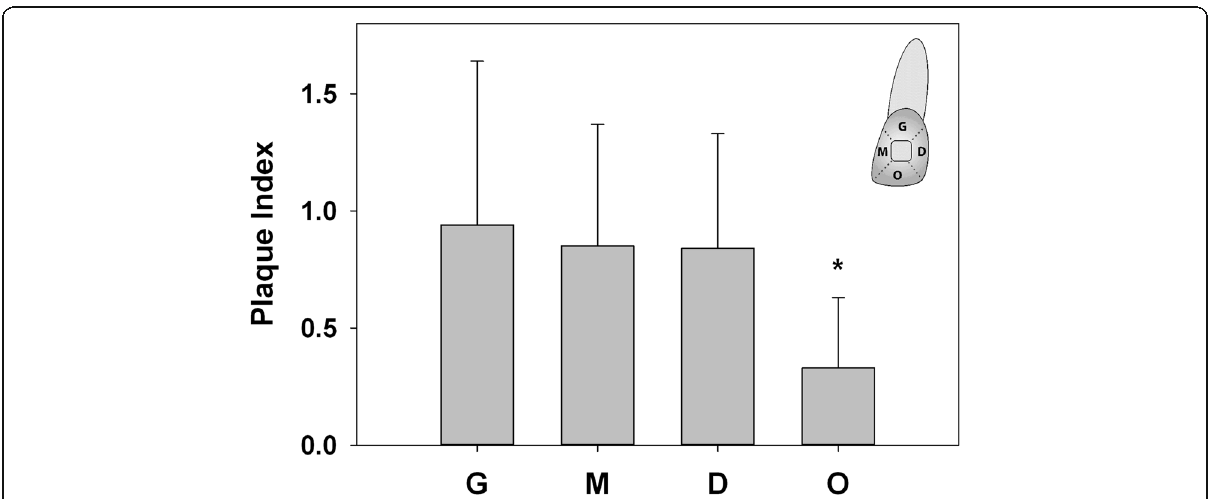
Fig. 1 Biofilm formation on the four areas of a tooth in relation to the bracket ( G gingival, M mesial, D distal, O occlusal). The occlusal area accumulated the least amount of biofilm compared with the gingival, mesial, and distal areas ( P < 0.038). No significant difference was found among the gingival, mesial, and distal areas ( P >